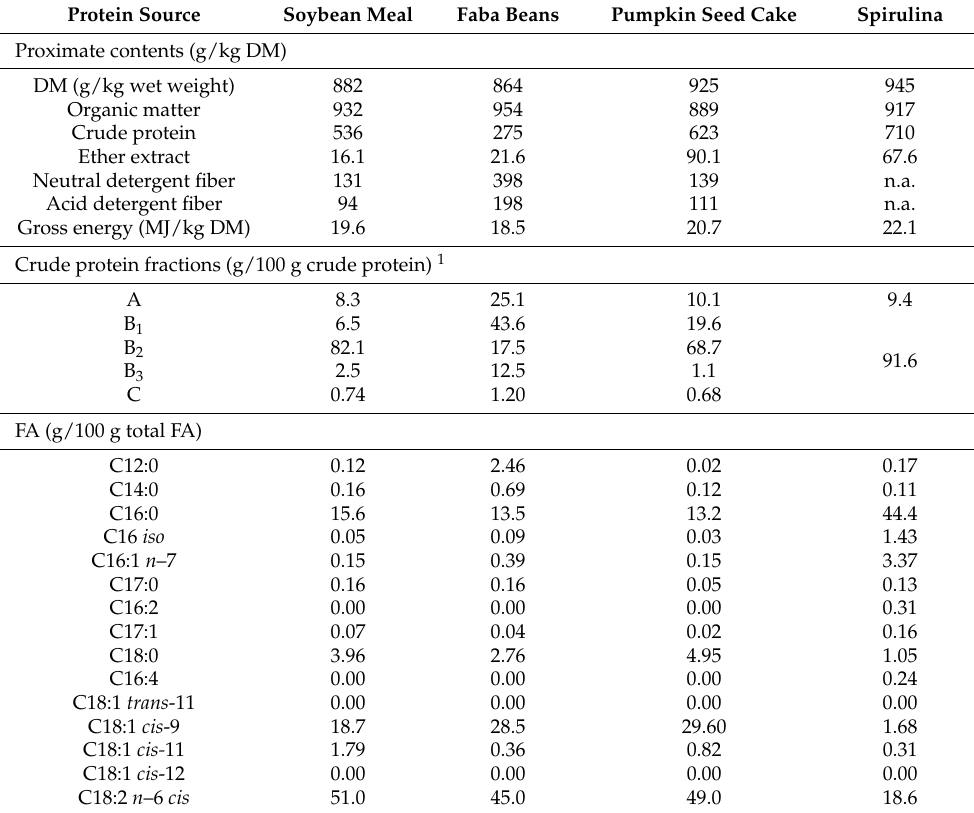
Table 1. Chemical composition and selected fatty acids (FA) of tested protein sources. Protein Source Soybean Meal Faba